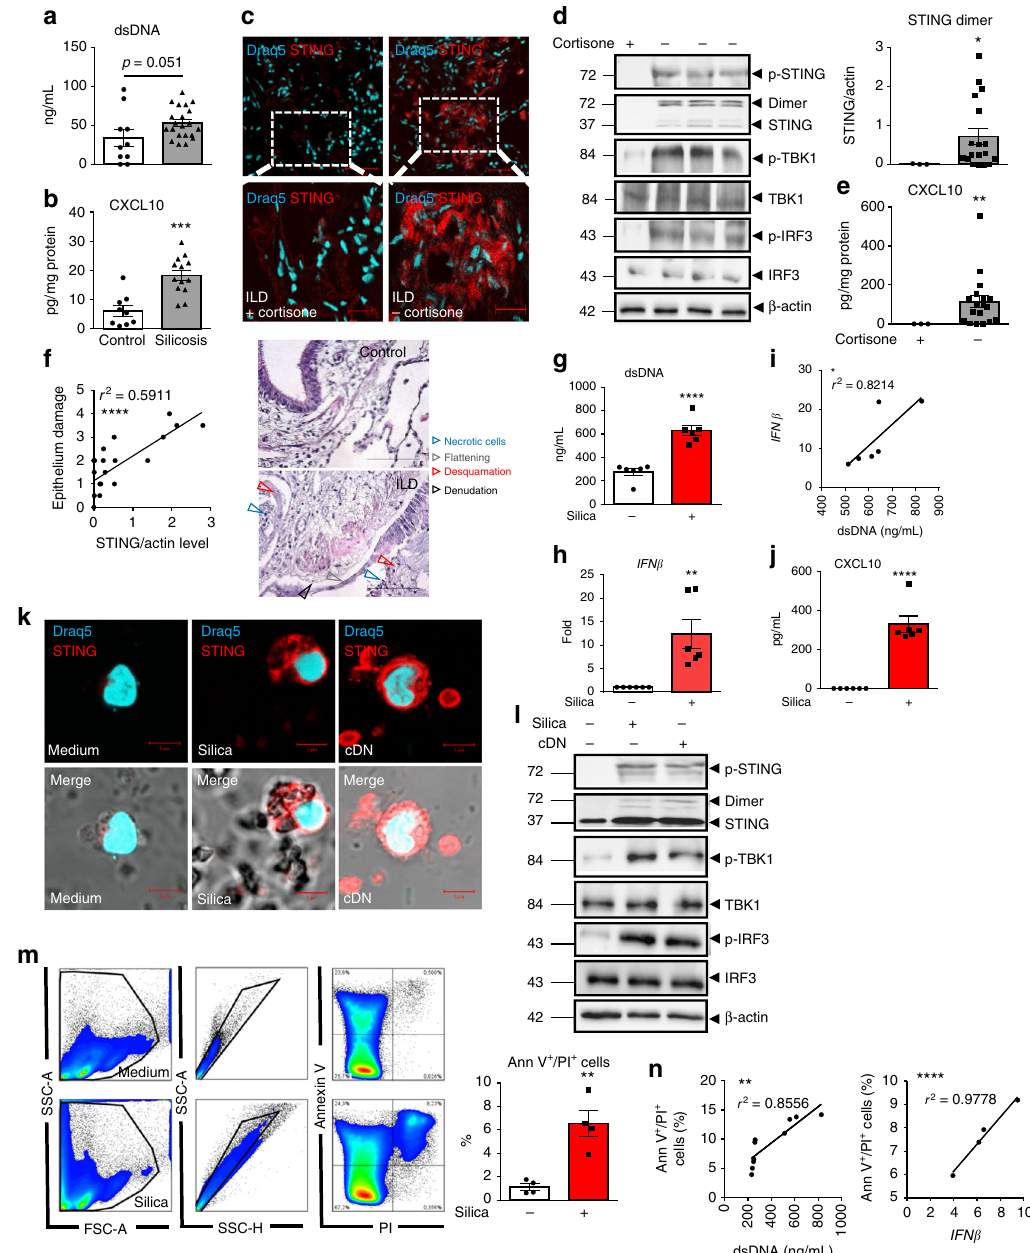
Fig. 2 Circulating DNA and CXCL10 in the airways of silicosis patients, STING, and type I IFN pathway activation in ILD patient lungs. a , b Presence of ( a ) dsDNA in the plasma and ( b ) CXCL10 in the sputum of patients with silicosis (ILO 5 – 12, see Table 1), as compared with healthy individuals (ILO 0). c – f Human lung tissue samples of ILD patients treated or not with cortisone (see Table 2). c Confocal images of DNA dye Draq5 (cyan) and STING (red). Bars, 50 µ m. Bars, 20 µ m for zoomed regions. d Immunoblots of phosphorylated-STING (p-STING), STING, TBK1, phospho-TBK1, IRF3, phospho-IRF3, and β -actin. STING dimers quanti fi cation. e CXCL10 levels. f Correlation between STING dimers and epithelial damage scored on human histological tissue